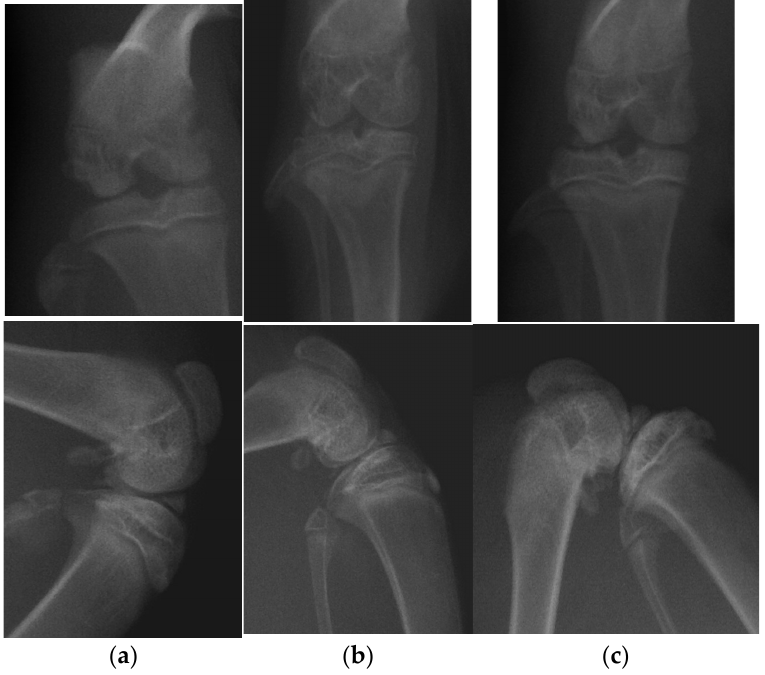
Figure 1. Antero-posterior ( upper panel ) and lateral ( lower panel ) radiographs of the right knee joint of ( a ) running rat, ( b ) immobilised rat, ( c ) walking rat.